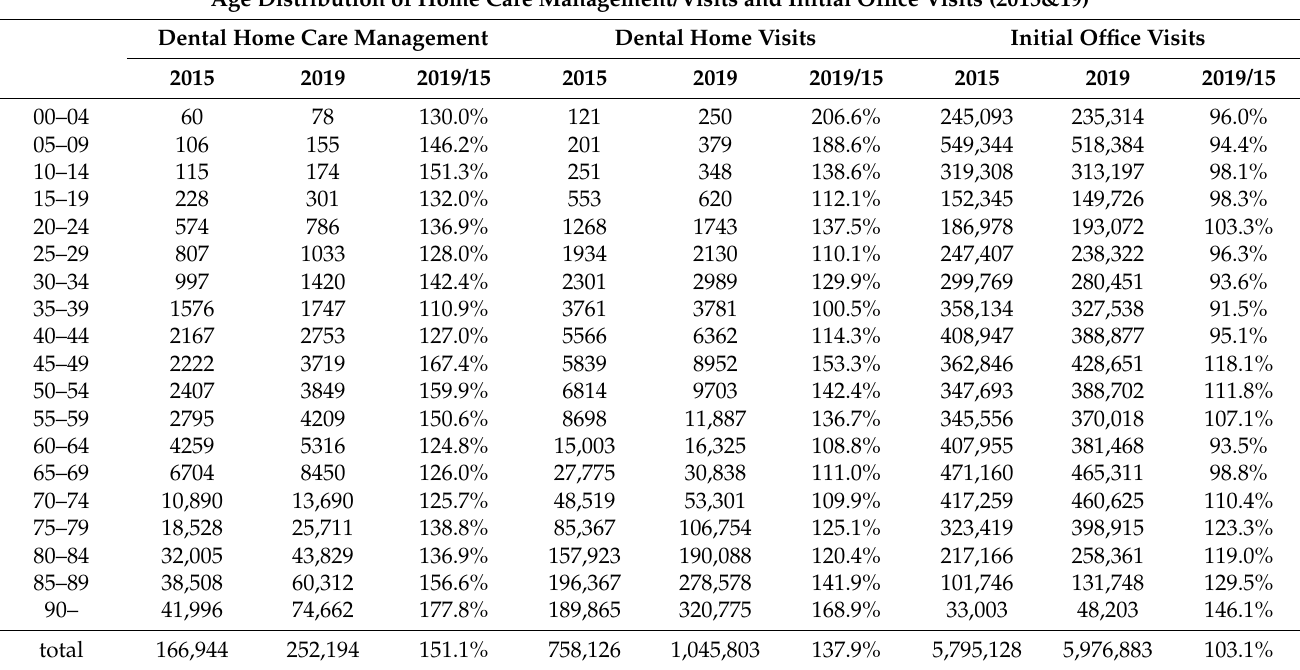
Table 7. Age distribution of home care/visits and initial office visits (2015 and